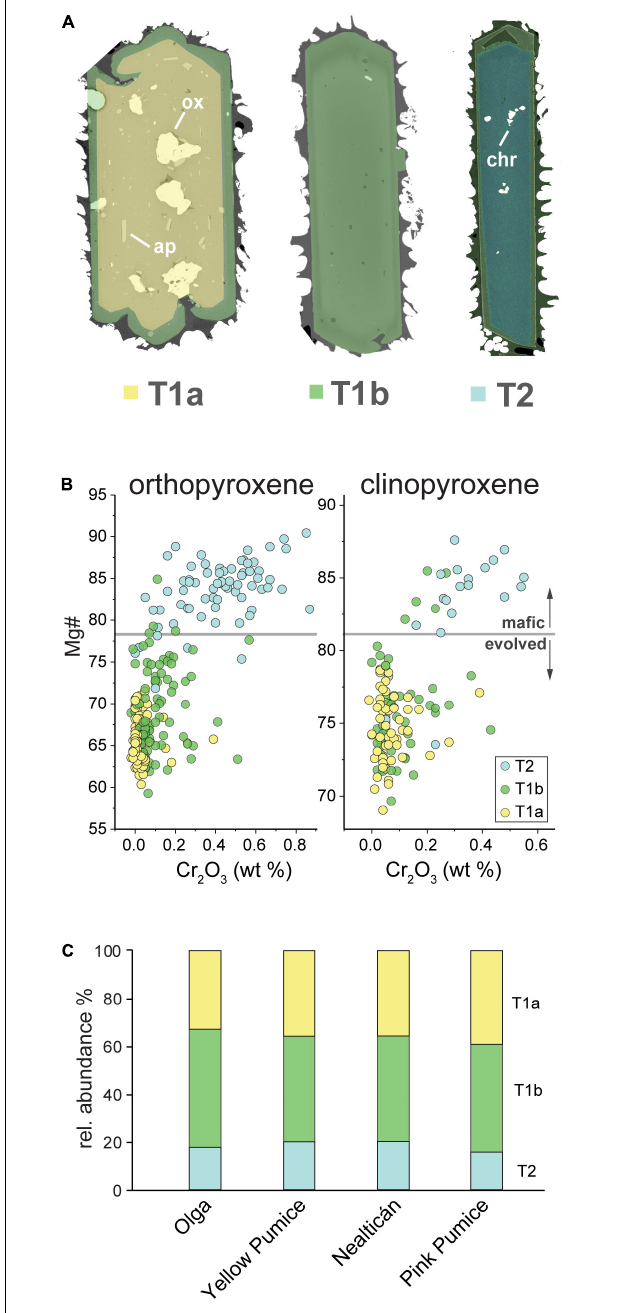
FIGURE 4 | (A) Orthopyroxene philocrysts showing representative features of evolved Type 1a (T1a, yellow), Type 1b (T1b, green), nad mafic Type 2 (T2, blue) crystal cores, colorized by type and with common inclusions labeled. ox = Fe-Ti oxides. ap = apatite. chr = Cr-spinel. See text for explanation. (B) Mg# vs. Cr 2 O 3 concentrations in ortho- and clinopyroxene cores, showing that T2 crystals > Mg# 78 (orthopyroxene)/ > Mg# 82 (clinopyroxene) are characterized by > 0.25 wt. Cr 2 O 3 , while T1a crystals generally show < 0.25 wt.% Cr 2 O 3 . T1b crystals tend to slightly higher Mg# and Cr 2 O 3 concentrations than T1a crystals. (C) Relative abundances in of T1a, T1b, and T2 ortho- and clinopyroxene in lavas and pumices erupted in the past ∼ 14 ka (n min = 300